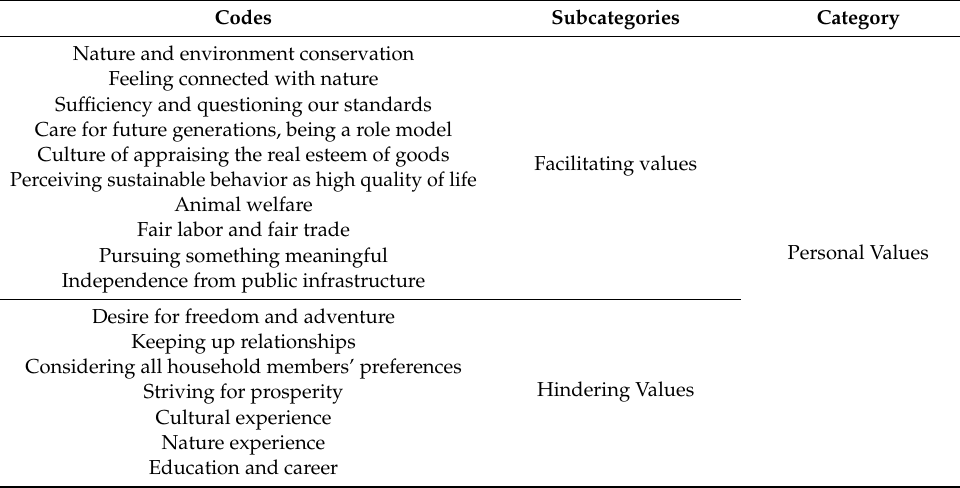
Table 5. Codes in the two subcategories of personal